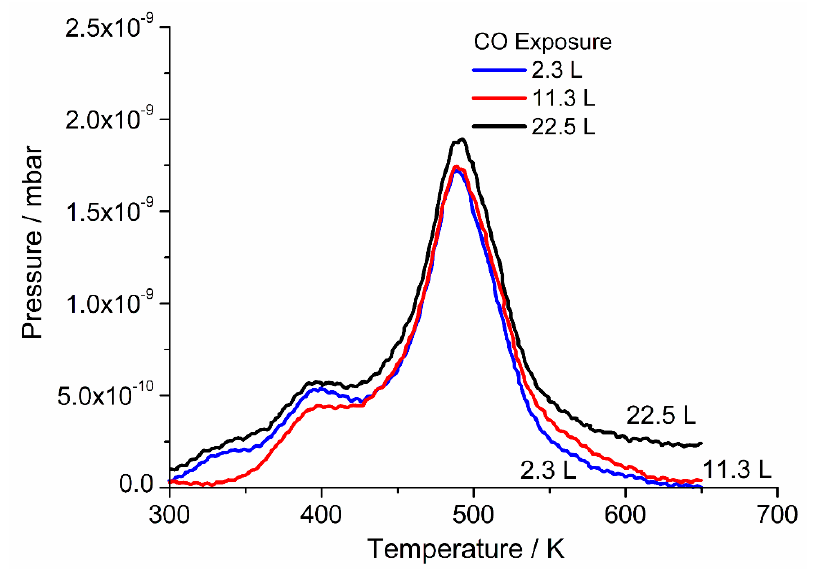
Figure 6. TPD-spectra of CO on Pt{110} for different exposures, as indicated in the figure. The sample was dosed at 200 K with a CO pressure of 5 × 10 − 8 mbar. The heating rate was 3 K/s.